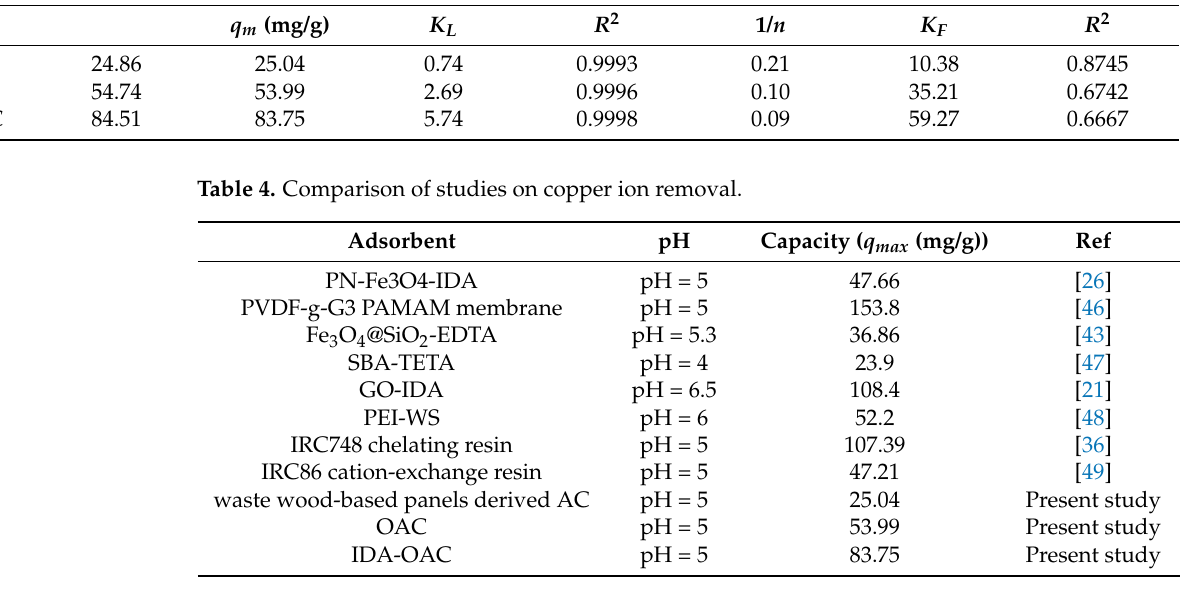
OAC adsorption for Cu(II). adsorption for Cu(II).